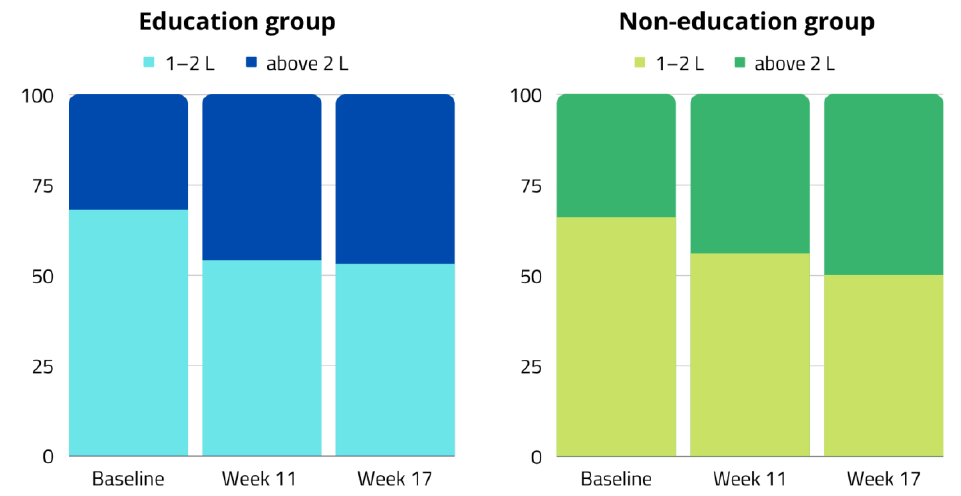
Figure 3. Changes in percentages of daily water consumption by participants noticed during follow-up.